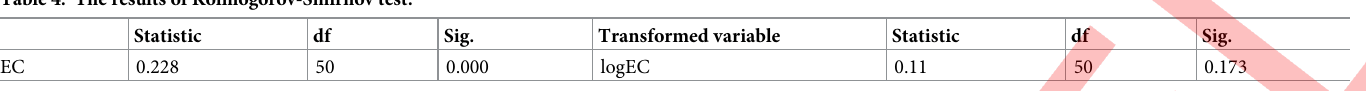
Table 4. The results of Kolmogorov-Smirnov test.